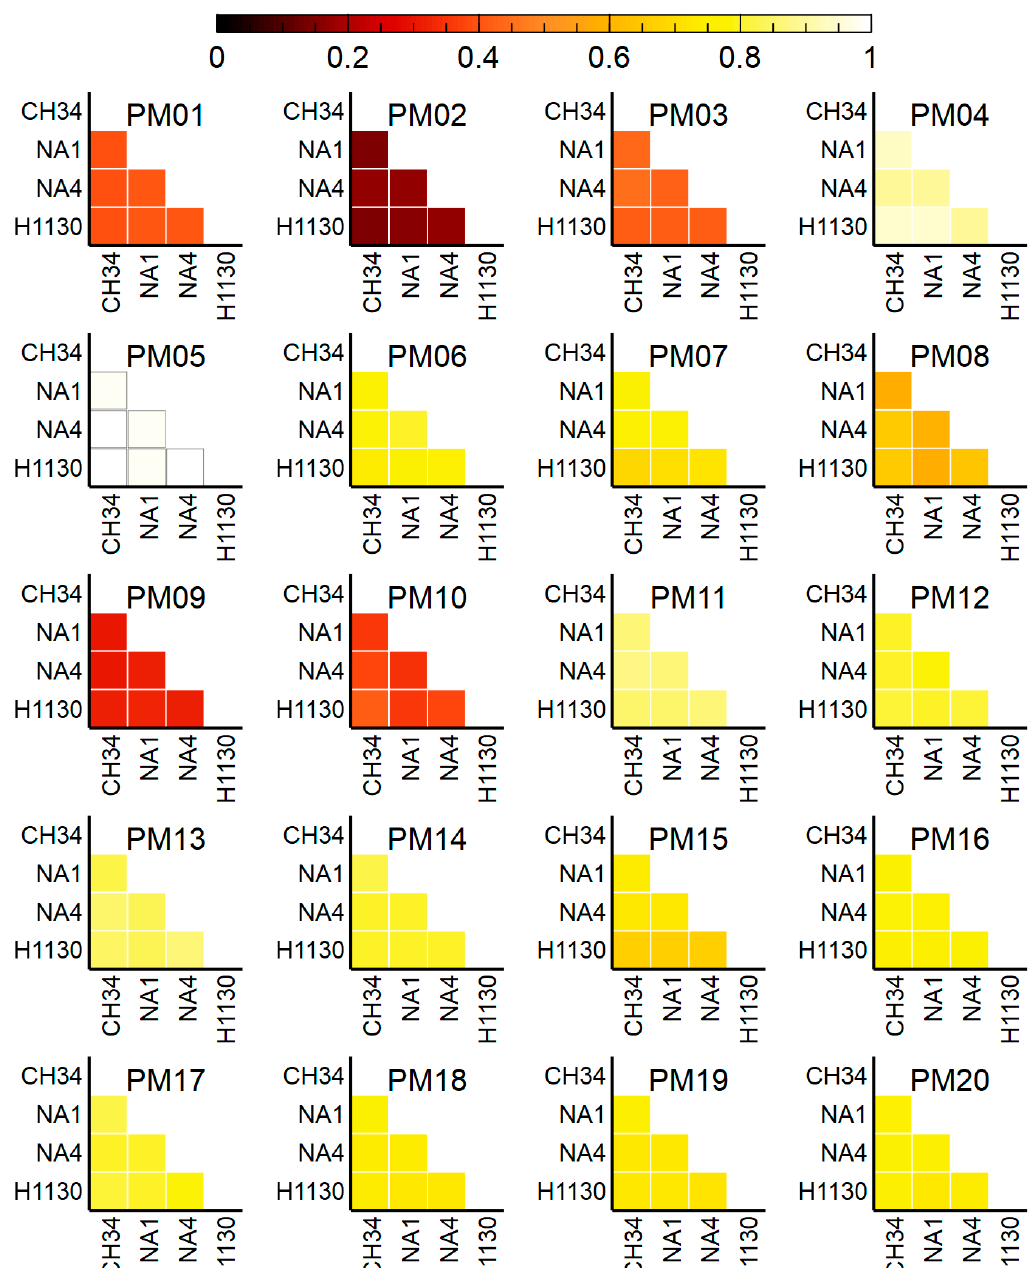
Figure 10. Overview of positive (growth) OmniLog phenotypic assays shared by C. metallidurans CH34, NA1, NA4 and H1130 for each PM plate (with 1 being all 96 assays). The assays on each PM plate are detailed in Table S4.